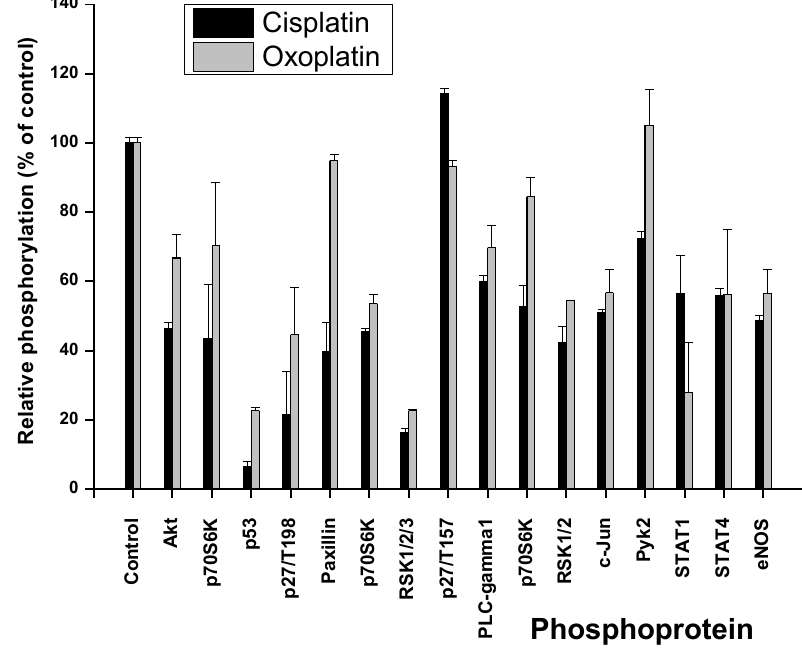
Figure 3. Comparison of the phosphoprotein response of NCI-H526 cells to short-term exposure to cisplatin and oxoplatin, respectively. Status of the phosphorylation of the proteins covered by array part B is presented as percentage of the untreated control cells (±SD; all differences between oxoplatin and cisplatin exposure are significant with p < 0.46, except for p70S6K, p27/T198, PLCγ1, c-JUN, STAT4 and